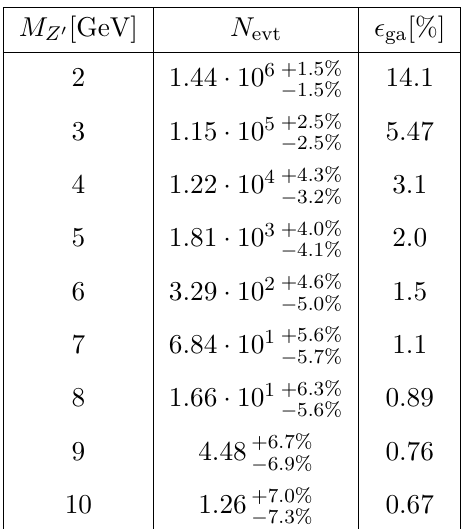
Table 2. Number of DIS dark matter scattering events ( N evt ) as a function of the mass of the Z 0 mediator for the benchmark point reported in the listing in appendix D.2. (cid:15) ga is the geometrical acceptance of the